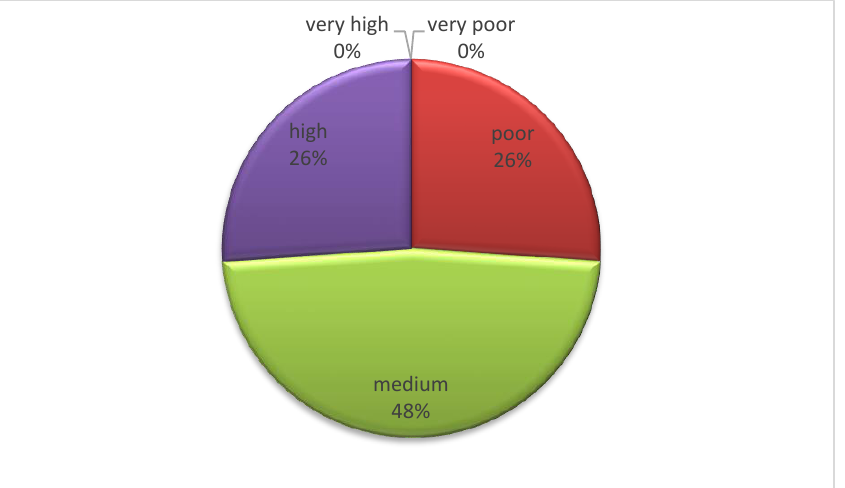
Figure 3. Ibnu Thufail Students’ HOTS based on Logic and Reasoning Indicator in